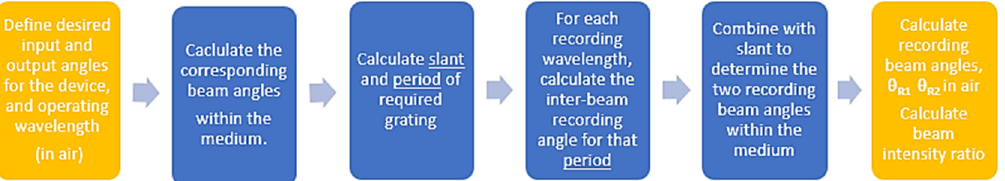
Figure 2. Flowchart showing how the recording angles are calculated using the